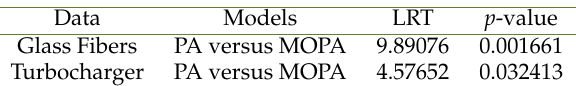
Table 9. The values of LRT and its p-value for every